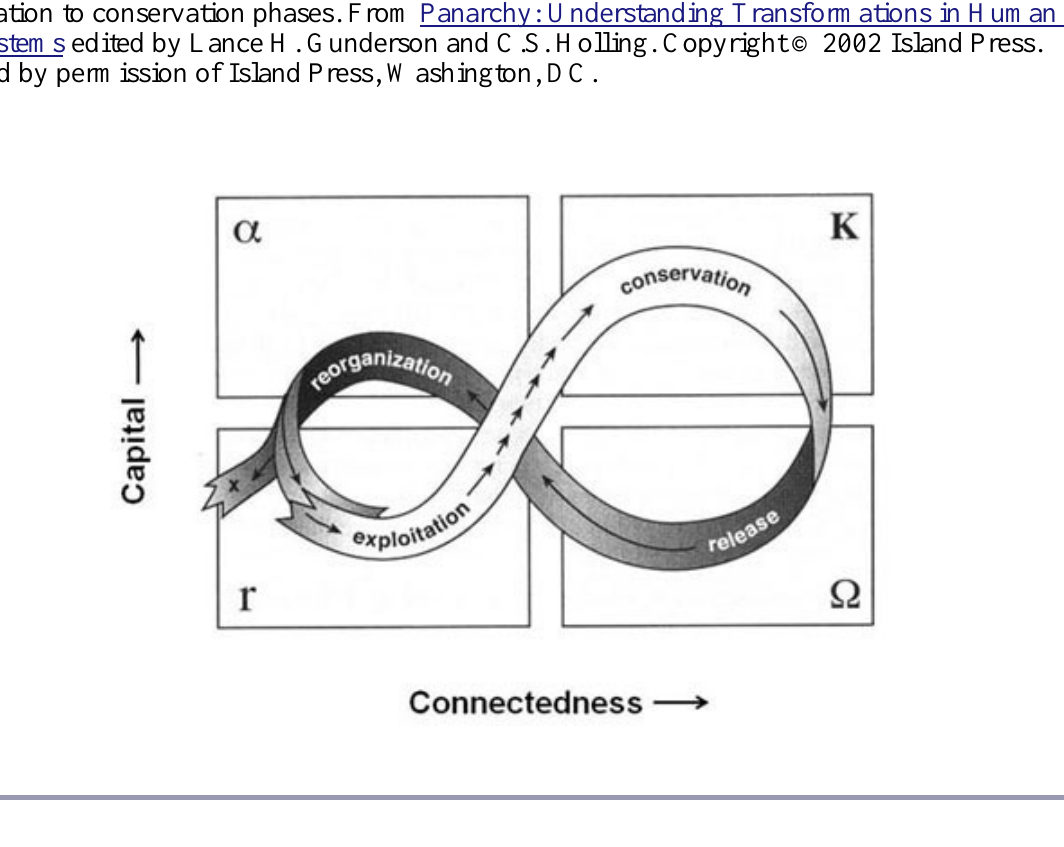
Fig. 2. Adaptive cycle showing the increase in capital accumulation (potential) and connectedness from the exploitation to conservation phases. From Panarchy: Understanding Transformations in Human and Natural Systems edited by Lance H. Gunderson and C.S. Holling. Copyright © 2002 Island Press. Reproduced by permission of Island Press, Washington,